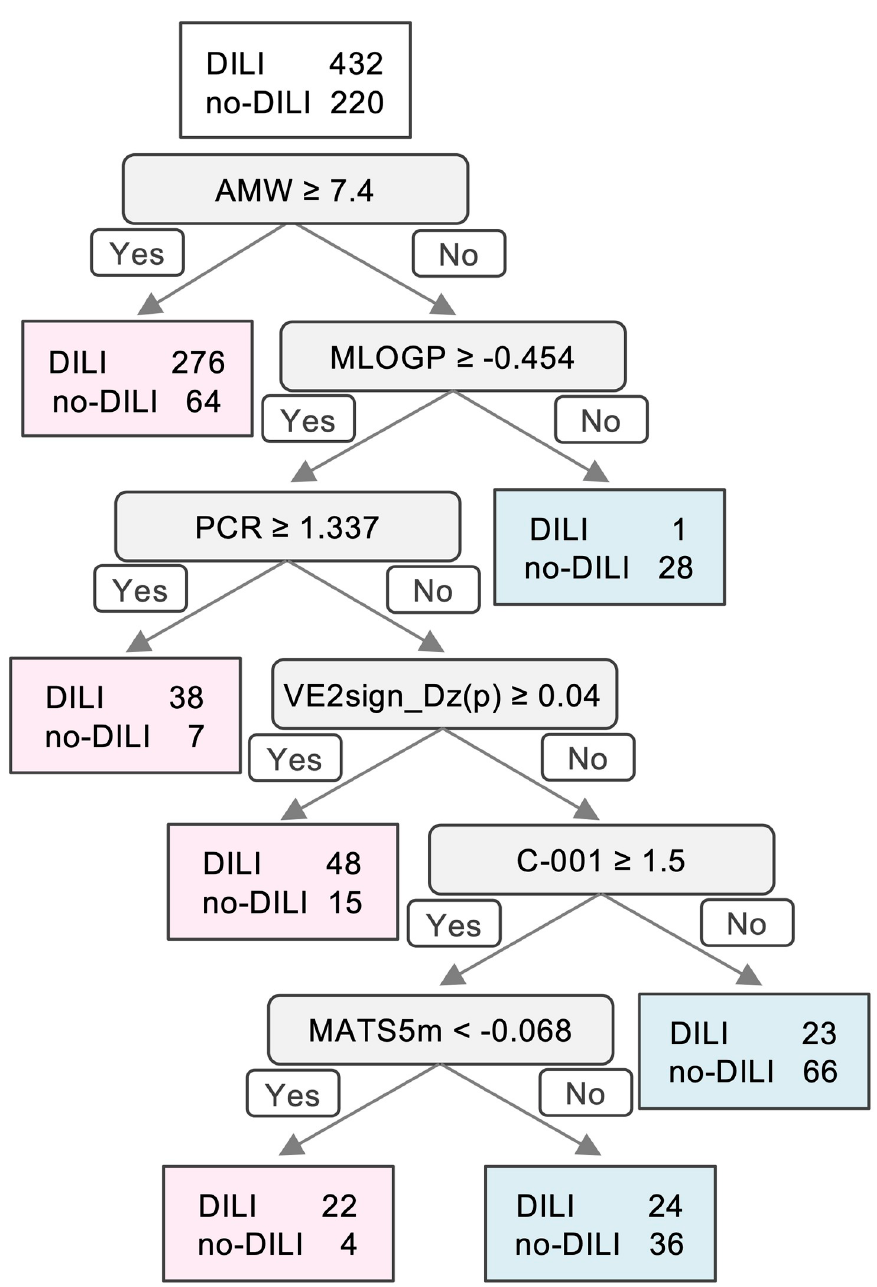
Fig 3. The final tree model for the discrimination between DILI drugs and no-DILI drugs. A decision tree model was constructed, and its accuracy, sensitivity, specificity and BA were calculated. Descriptor abbreviations are: PCR, ratio of multiple path count over path count; VE2sign_Dz(p), average coefficient of the last eigenvector from Barysz matrix weighted by polarizability; C-001, CH3R / CH4; MATS5m, Moran autocorrelation of lag 5 weighted by